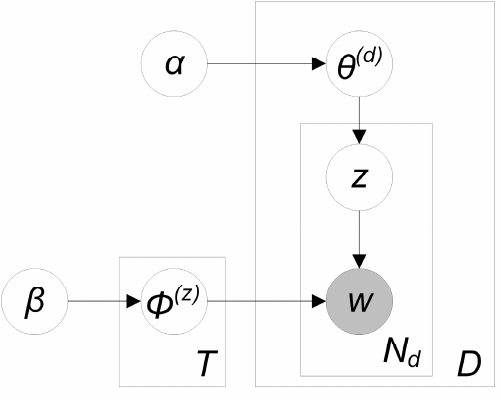
Figure 3. LDA plate notation [74].